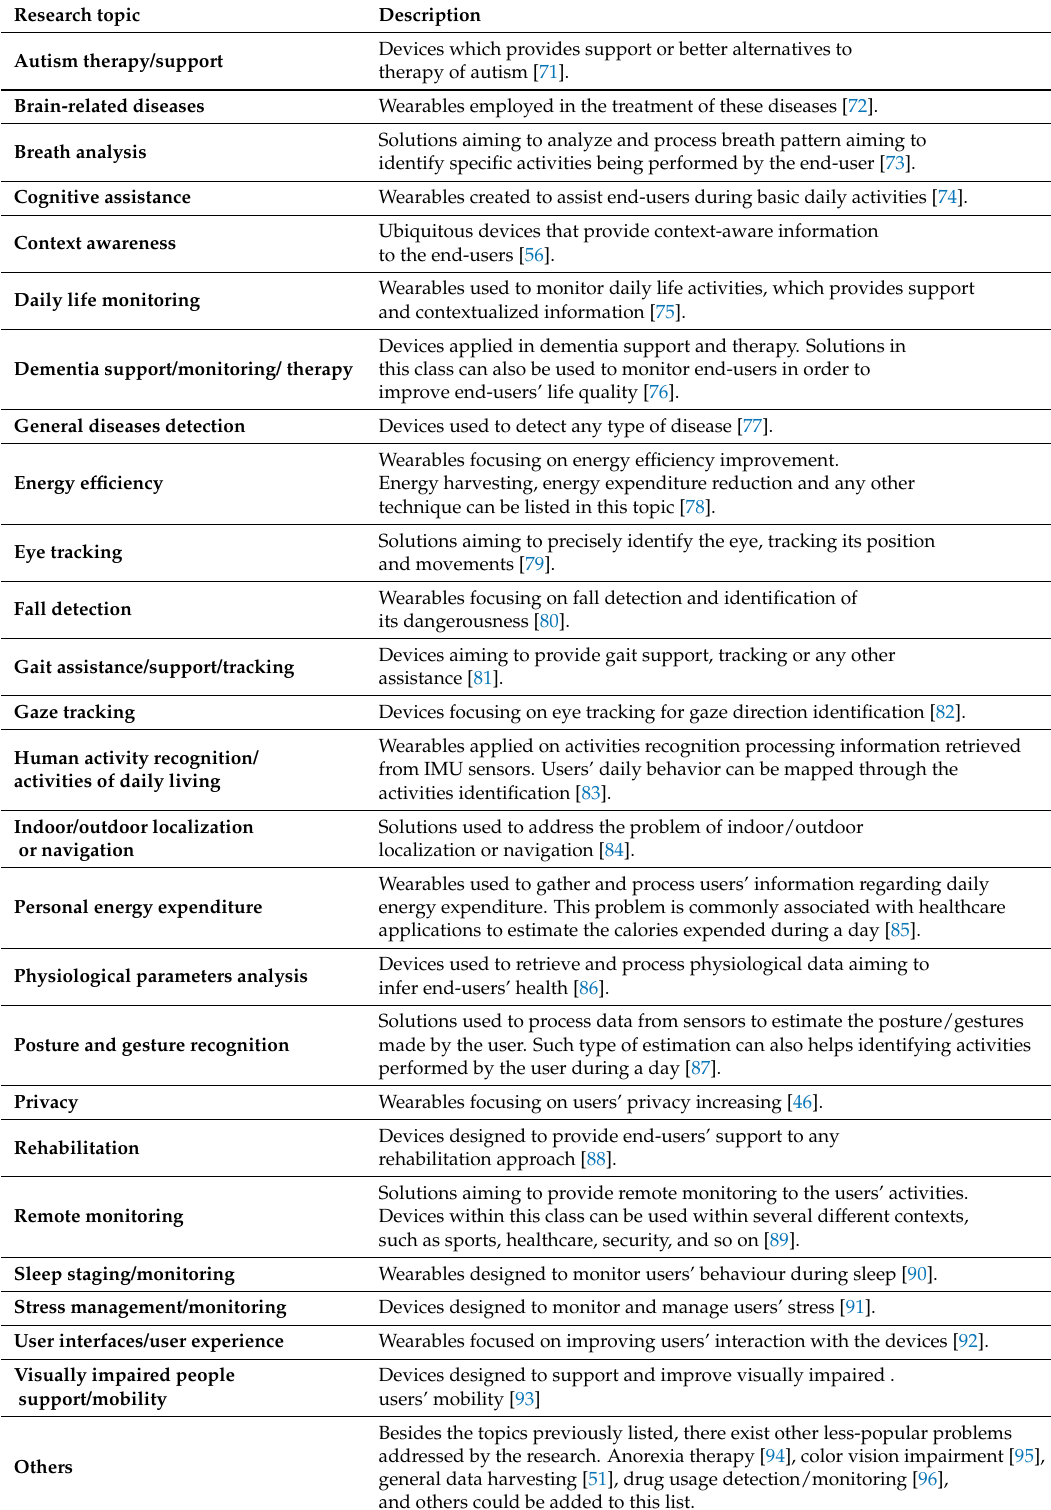
Table 3. Common topics addressed by wearable devices research and